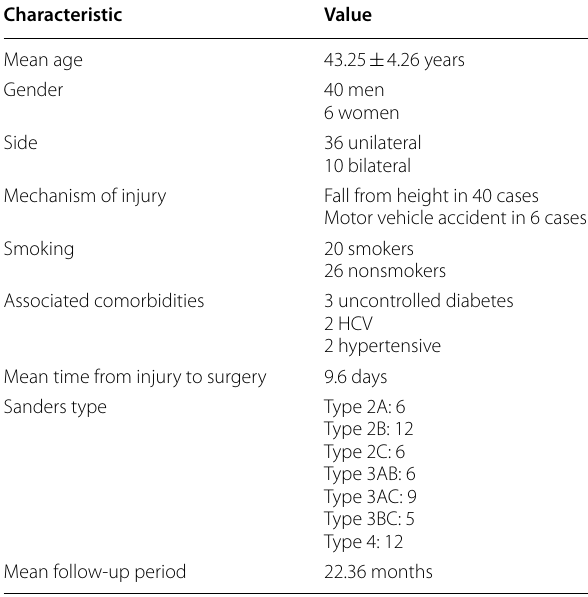
N 56 feet in 46 =